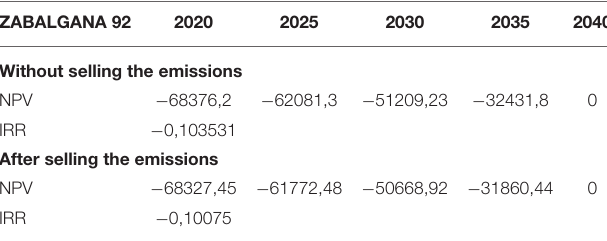
TABLE 3 | NPV and IRR for the installation of the solar thermal system in ARRASATE